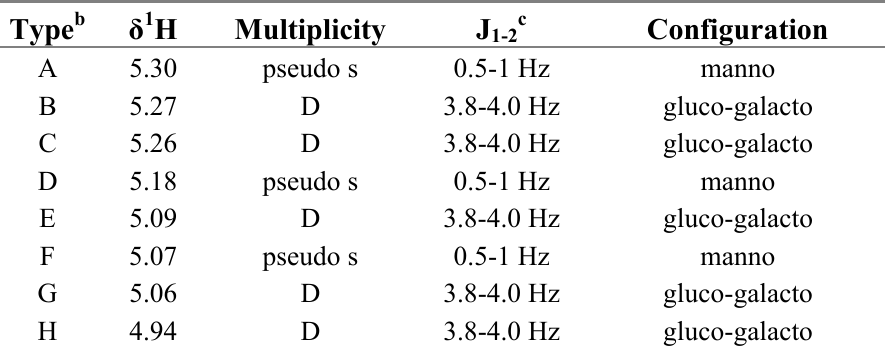
Table 3. 1 H-NMR data a for the anomeric region of the spectrum of tomato waste Sample A .